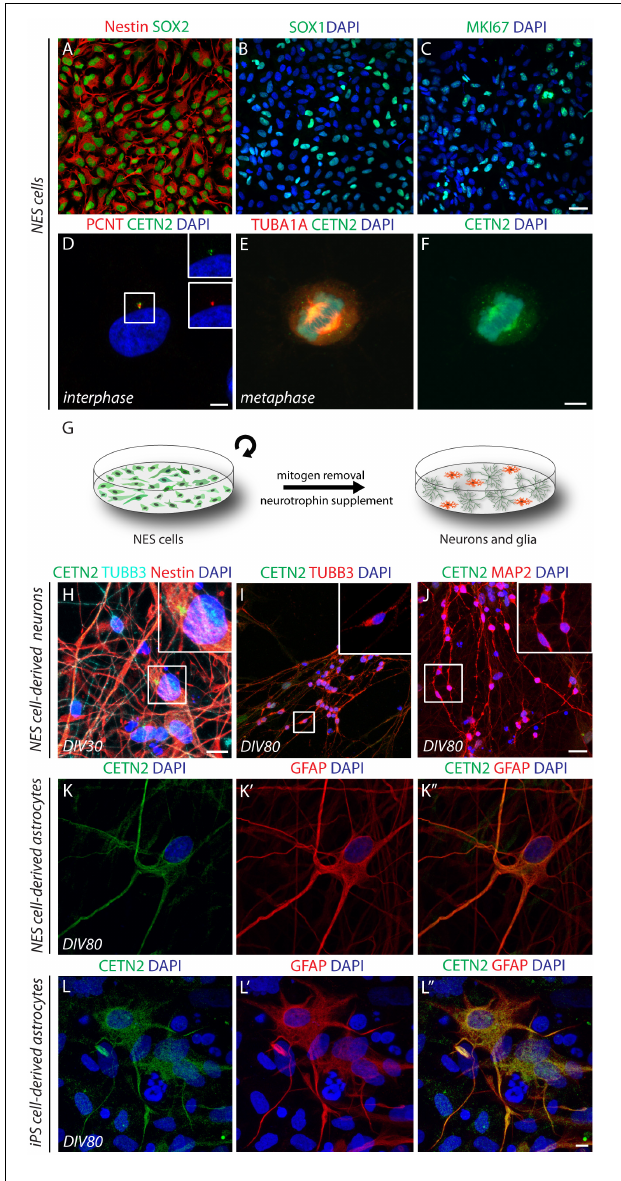
FIGURE 1 | Cell-type specificity of centrin-2 (CETN2) expression in human neuroepithelial stem (NES) cells and induced pluripotent stem (iPS) cell progeny. (A,B) Human NES cells express canonical neural stem cell marker nestin and transcription factors SOX2 and SOX1. (C) Active cell proliferation is attested by MKI67 labeling. (D–F) CETN2 labels centrosomes and co-localizes with pericentrin (PCNT) during interphase, while it immunodecorates mitotic spindle poles during metaphase. (G) Graphical protocol for NES cell differentiation into mature neurons and glial cells. (H) Upon 30 days in vitro (DIV), NES-cell β -III tubulin (TUBB3)-labeled neuronal progeny is intermingled with nestin-positive NES cells, which retain centrosomal CETN2 expression (shown in inset). (I,J) NES cell-derived neurons at 80 DIV are immunopositive for TUBB3 and microtubule-associated protein-2 (MAP2). High magnification insets show no detectable centrosomal CETN2. (K–K”) NES cell-derived astrocytes at 80 DIV express cytoplasmic CETN2 co-localizing with the astrocytic marker glial fibrillary acidic protein (GFAP). (L–L”) Human iPS cell-derived astrocytes upon 80 DIV display similar cytoplasmic CETN2 localization and merge with GFAP staining. Scale bars: (A–C) 20 µ m; (D–F) 5 µ m; (H) 10 µ m; (I,J) 20 µ m; (K,L”) 5 µ